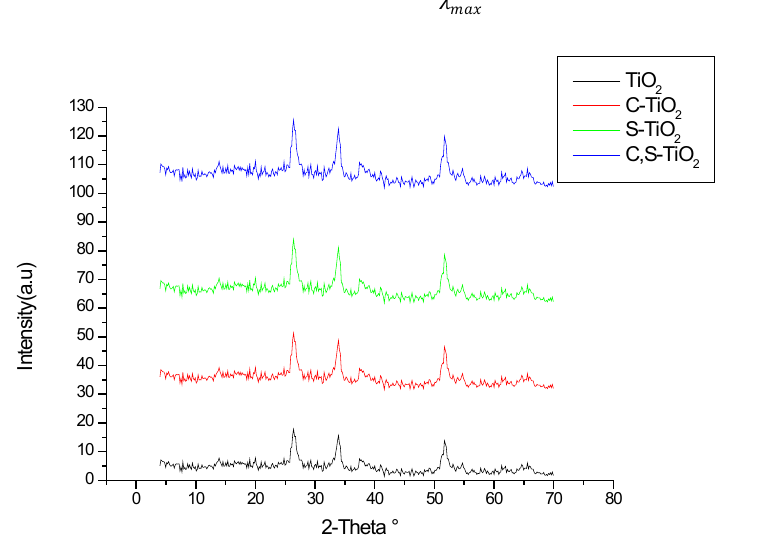
Fig. 1: XRD patterns of TiO